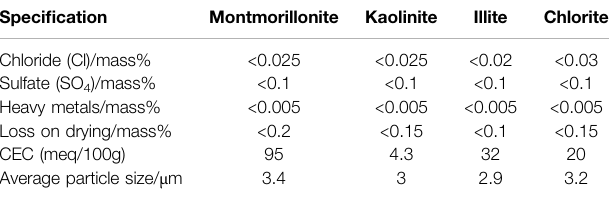
TABLE 3 | Characterization of different clay minerals.